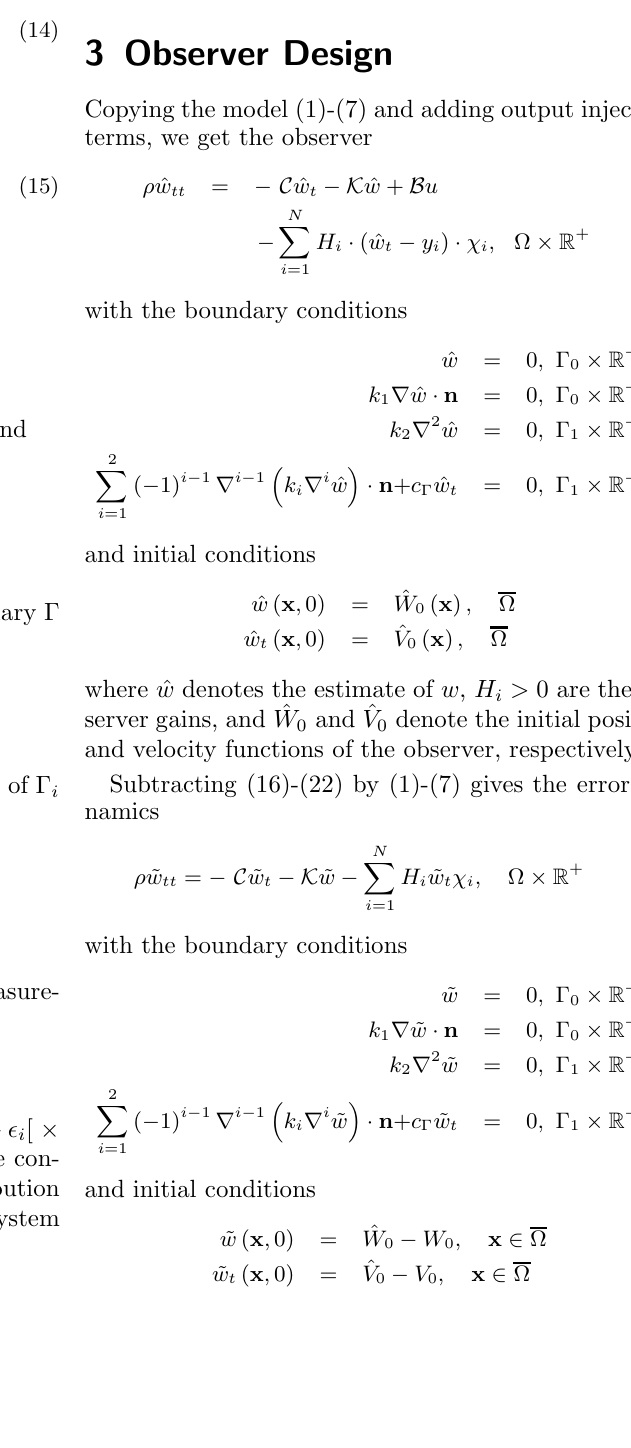
Figure 1: Distribution function χ